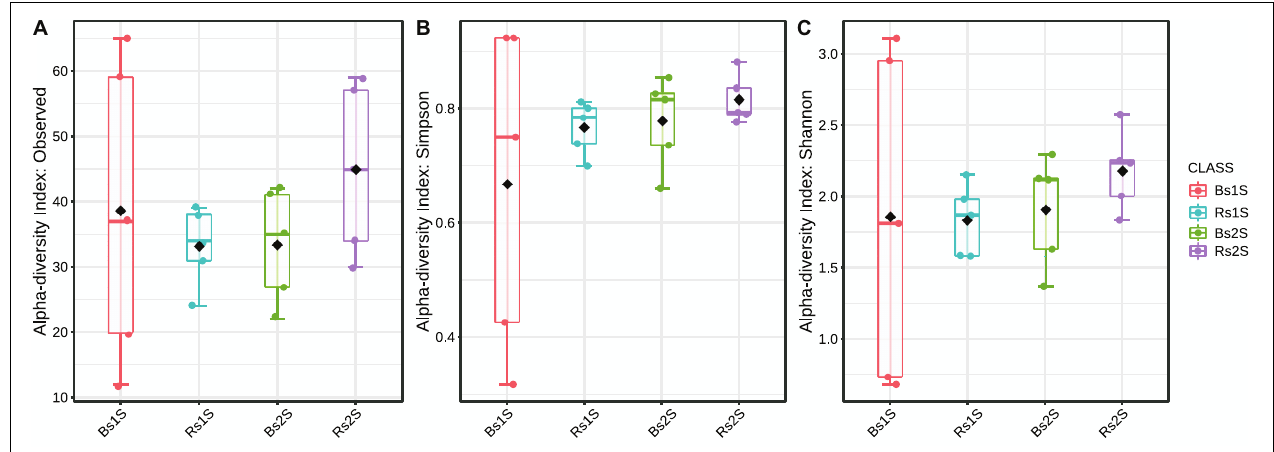
FIGURE 3 | Alpha diversity indices. (A) Number of observed arbuscular mycorrhizal fungi species ( p -value, 0.5393), (B) Simpson index ( p -value, 0.4700), and (C) Shannon’s index ( p -value, 0.8177) of biodiversity detected in the soils associated (Rs) or not (Bs) with the roots of Vitis vinifera cv. Pinot Noir at the two sampling times (1S = flowering and 2S = fruit development). Alpha diversity analysis was performed using the phyloseq package of MicrobiomeAnalyst, a freely available online software